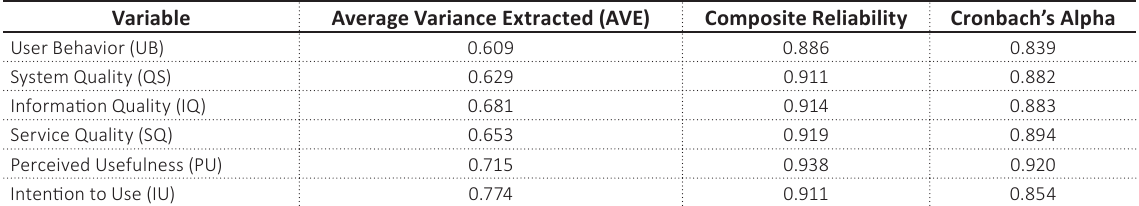
Table 4. Validity and reliability